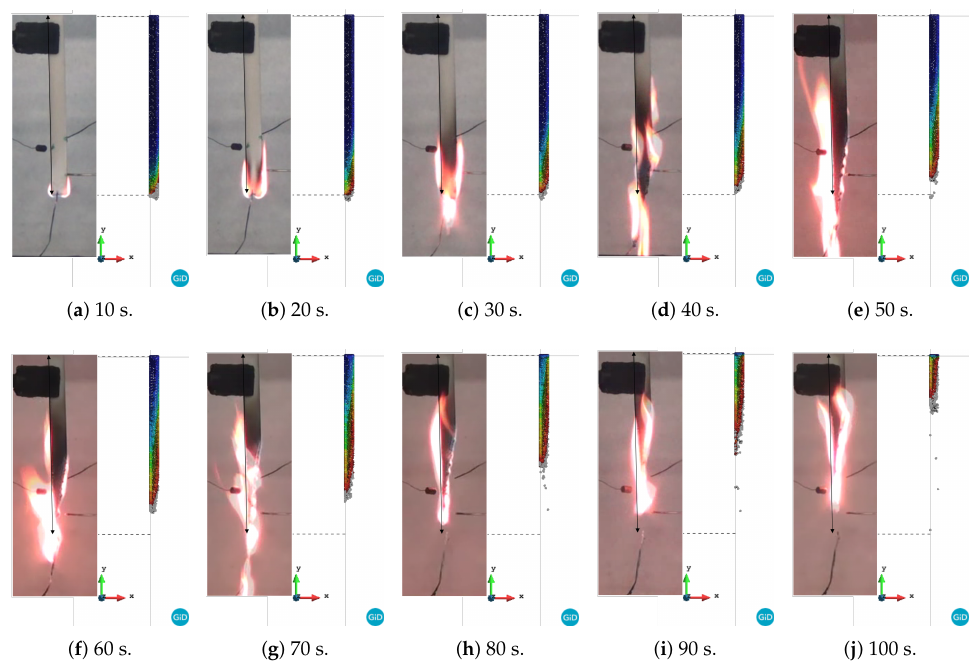
Figure 9. Comparison between experimental versus PFEM results for curve 2: blue and red corre- spond to 298 and 1000 K, respectively.